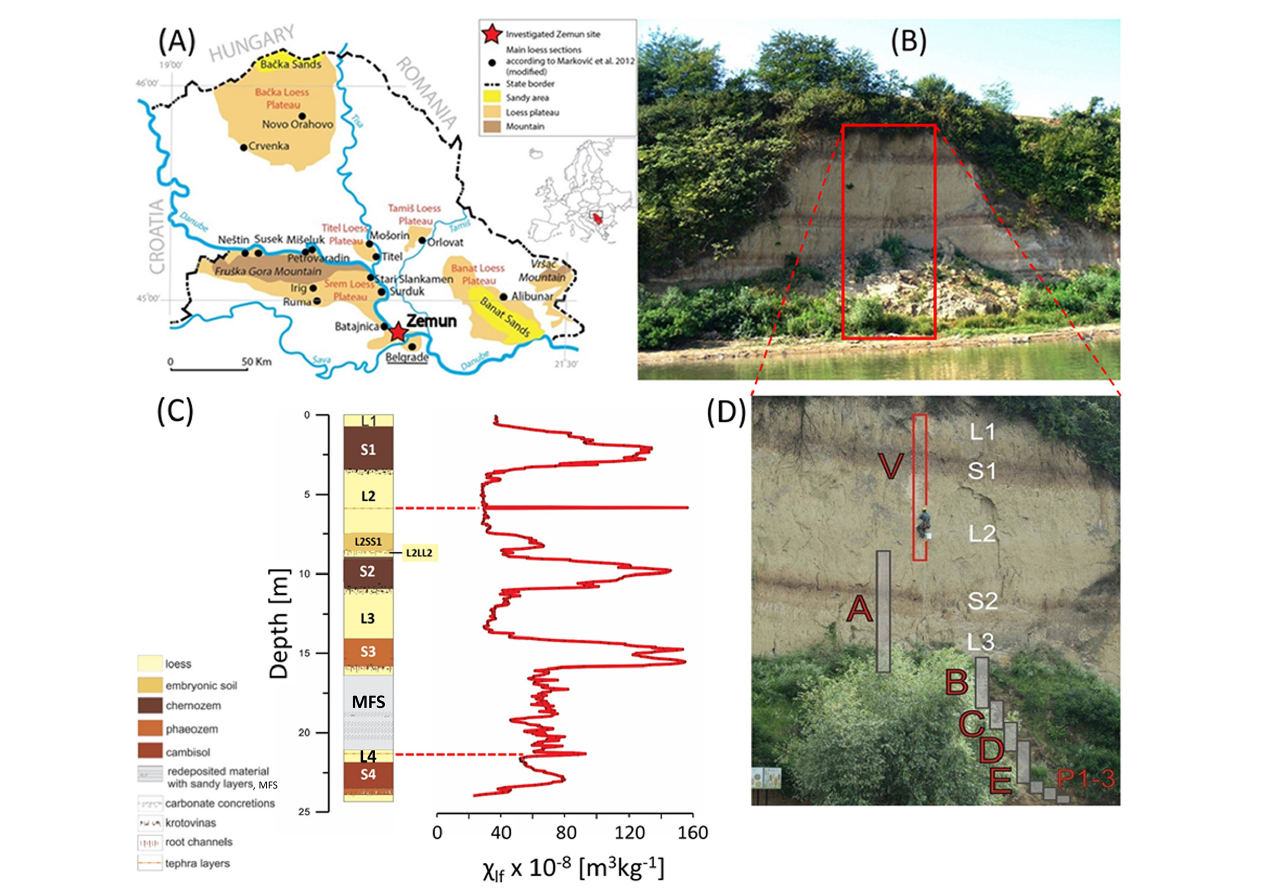
FIGURE 1 | (A) Regional map with the loess distribution of northern Serbia (southern Middle Danube Basin) and neighboring key-profiles, adapted from Gavrilovi´c et al. (2020). The Zemun LPS is indicated with a red star. (B) Photo of the studied Zemun LPS. Brownish layers are buried soils (paleosols). The studied section has a thickness of approximately 25 m. (C) Schematic drawing of the Zemun profile and the corresponding low-frequency magnetic susceptibility ( χ lf ) record highlighting (dashed lines) the anomalously high values associated to two tephra layers. (D) Sampling strategy with indicated sub-sections mentioned in the